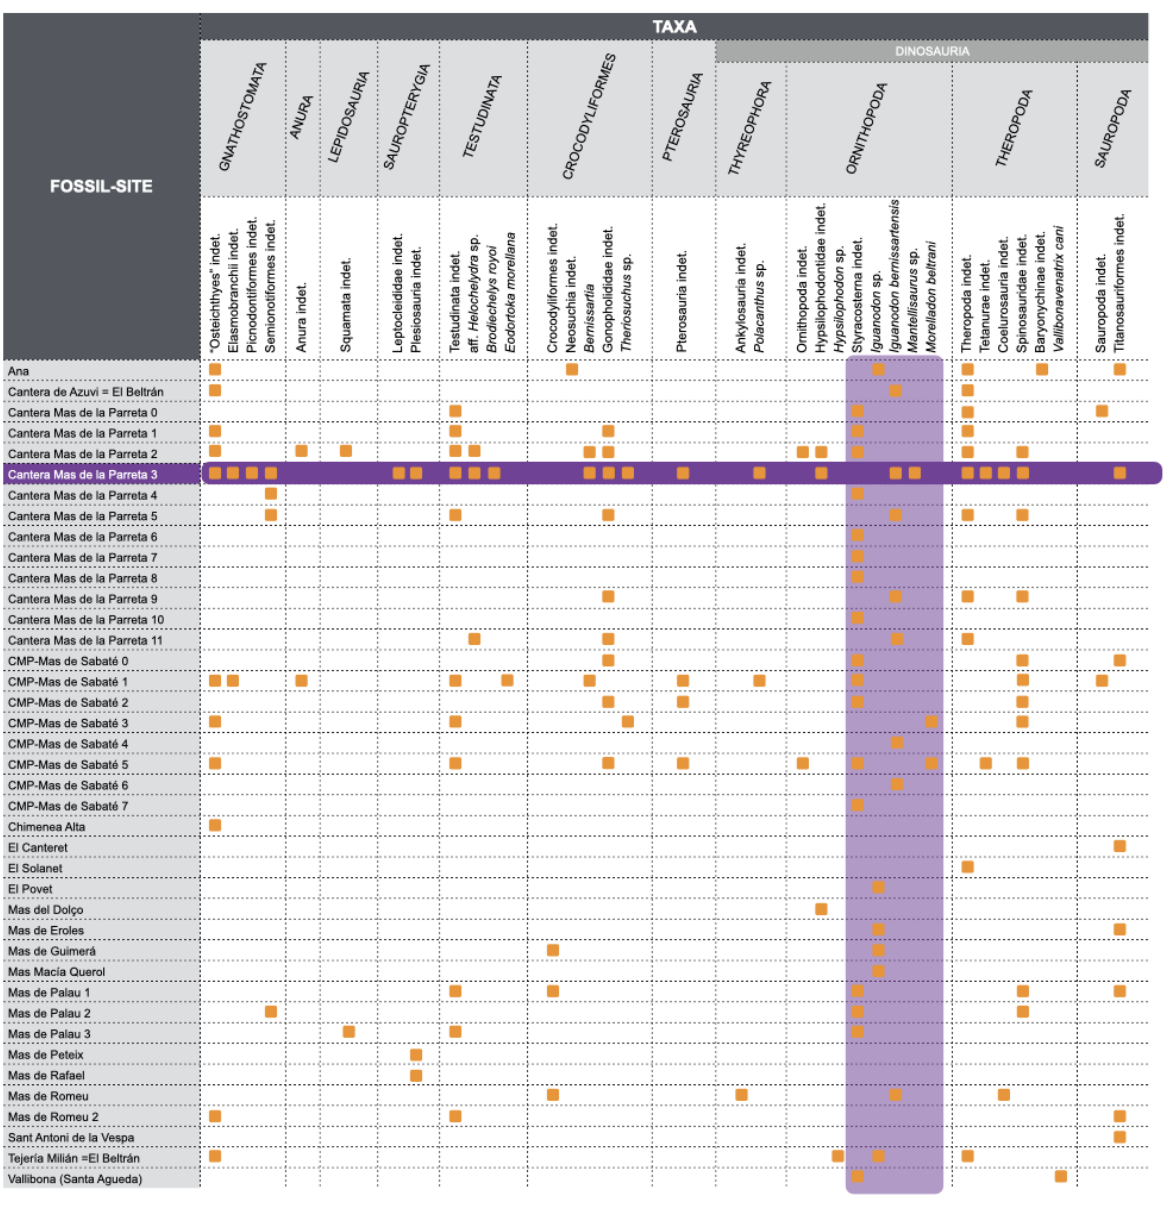
Figure 6. List of the vertebrate fauna recorded from the beds of the Arcillas de Morella Formation ([5] and references therein, [39,42,43]). Dark purple indicates Mas de la Parreta quarry site 3, whereas light purple indicates non-hadrosaurid styracosternan occurrences in the formation.